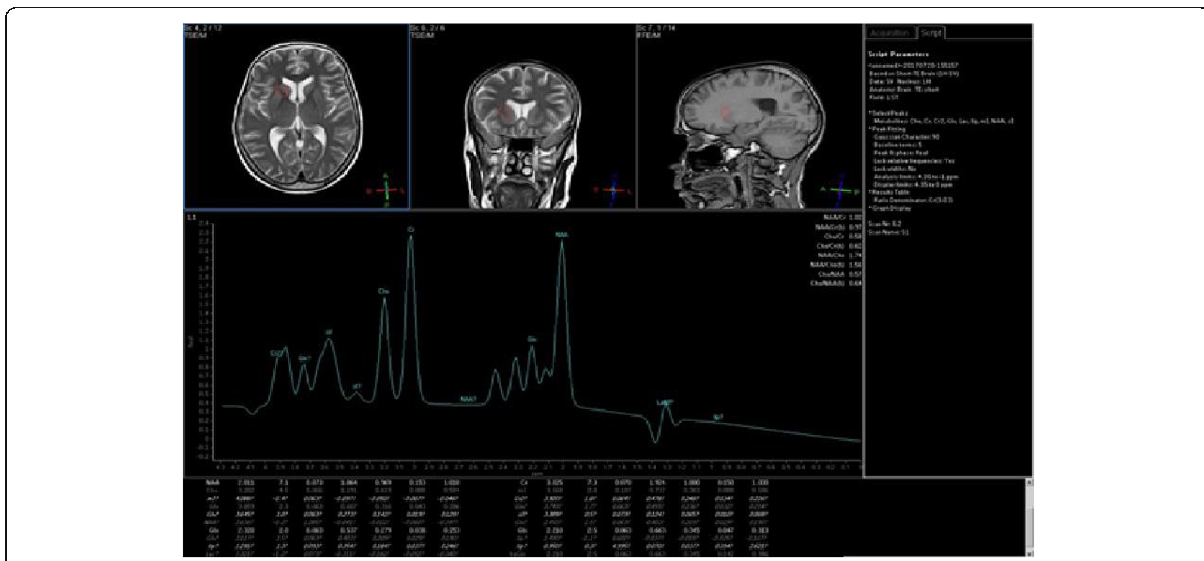
Fig. 1 MRS at basal ganglia in patients with cognitive impairment. Spectroscopic voxel of interest were done at basal ganglia in sagittal, coronal, and axial plans in patients with impaired attention/concentration/psychomotor score. Curve showed that NAA/Cr ratio was elevated ( R = 0.499 and p value = 0.026), and CHO/Cr ratio was reduced ( R = − 0.630 and p value =